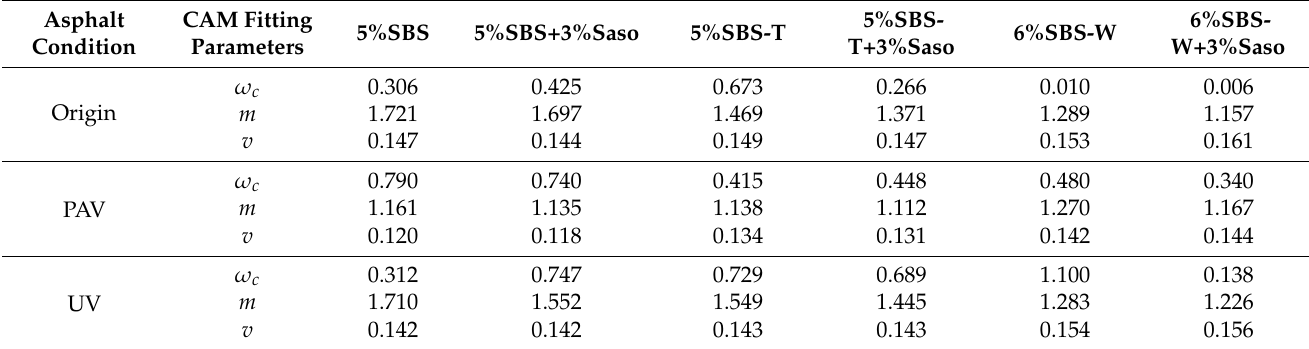
Table 7. CAM equation fitting parameters of modified asphalt.